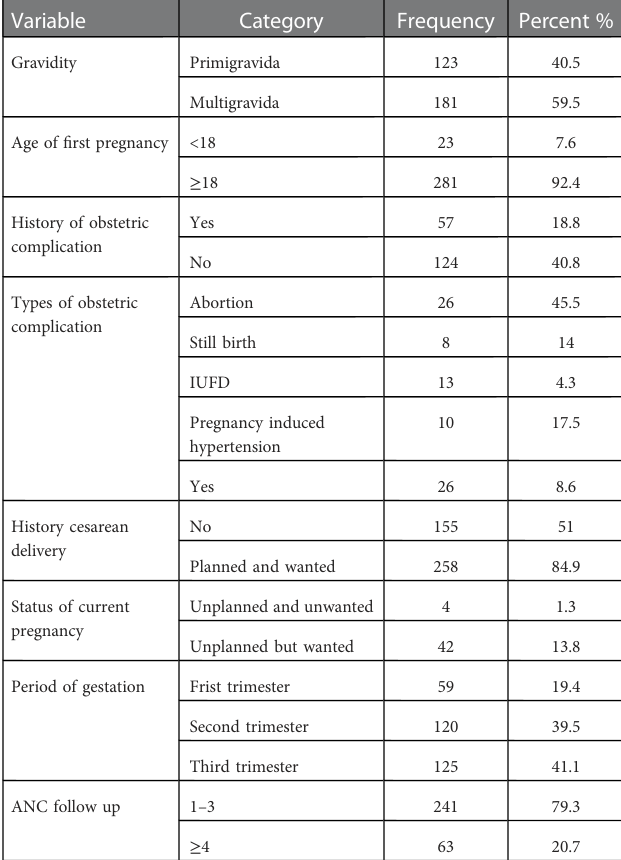
TABLE 2 Reproductive health characteristics pregnant women attending ANC at Debre Markos in a public institution of Debre Markos, north-west, Ethiopia, 2021 ( n